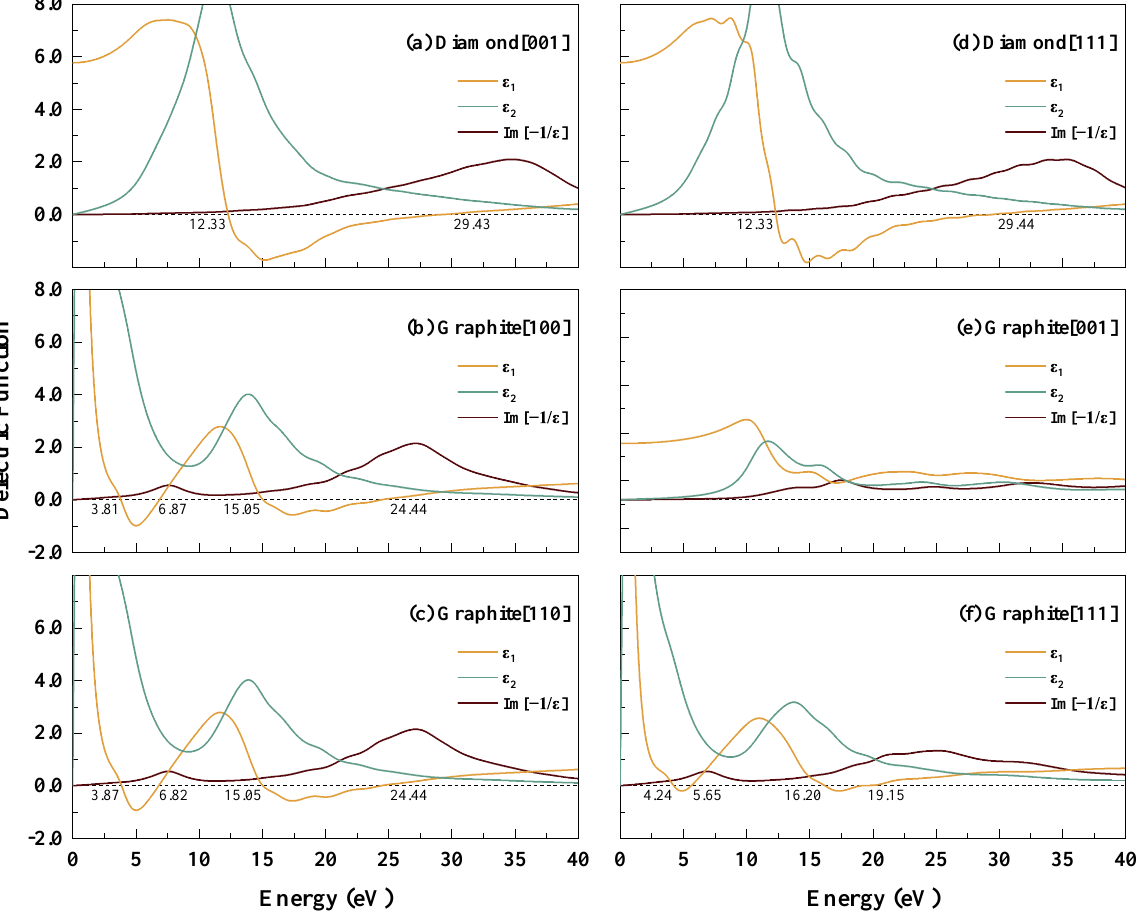
Figure 2. Dielectric functions and energy loss functions at the optical limit for the [001], [011], and [111] directions of diamond and the [100], [100], and [111] directions of graphite. The dielectric functions and energy loss functions of graphite in Figure 2d–f exhibit completely different behaviors from those of diamond. The properties of the [001] direction perpendicular to the carbon atomic layer are significantly different from the properties of the other two in-plane directions due to the different symmetry. The real part of the dielectric function ε 1 is always greater than zero in the [001] direction, indicating that there is no plasmon excitation in this direction. There is no strong peak on the energy loss function in the [001] direction. For the other two in-plane directions, on the contrary, there are two zeros for ε 1 and two main peaks on the energy loss function. It can be speculated that these zeros are coupled with collective plasmon excitations [15], but